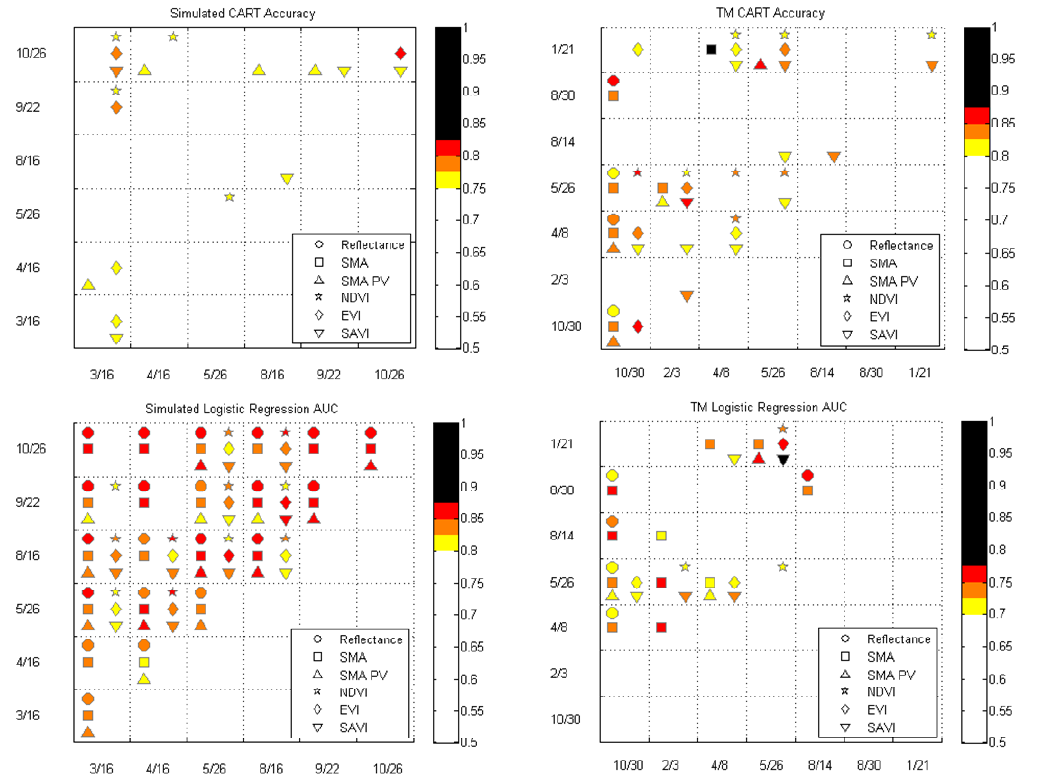
Figure 10. CART classification accuracy (top row) and logistic regression AUC (bottom row) of two-scene models for all date combinations using simulated (left column) and real Landsat TM data (right column). Each pixel represents the suite of models developed using the dates denoted by the column and row. Model types are Reflectance (o), SMA (square), SMA PV (triangle), NDVI (star), EVI (diamond), and SAVI (+). Accuracy and AUC are denoted by the color level. Note that axes differ between plots because of different acquisition dates, as do color levels due to large overall differences in accuracy and AUC between simulated and real TM